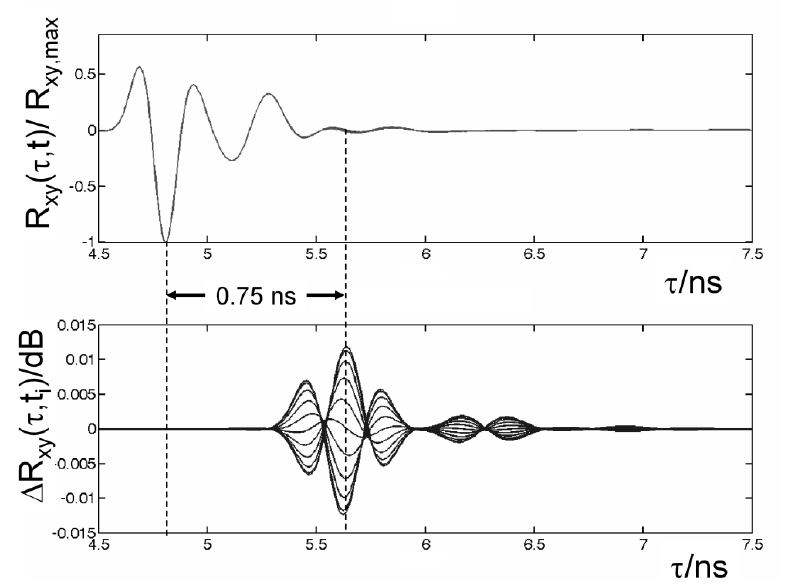
Figure 8. Upper : normalized overlapped correlation results R (  , t )/ R ,max gained from xy xy a sinusoidal oscillation of the intracranial white matter (10 discrete time steps per period). Lower : overlapped variation  R (  , t ) in R (  ) for each elongation, i.e ., each time step t . xy i xy i The envelope of  R corresponds to a 1 mm elongation. Indicated by  t = 0.75 ns is the xy two-way propagation time below the surface of the model where the maximum is